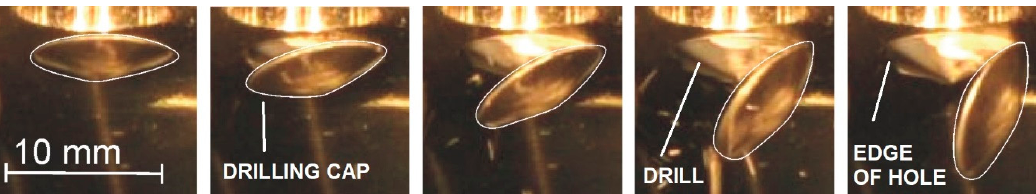
Figure 13. Burr height h as a function of axial drilling force F f .